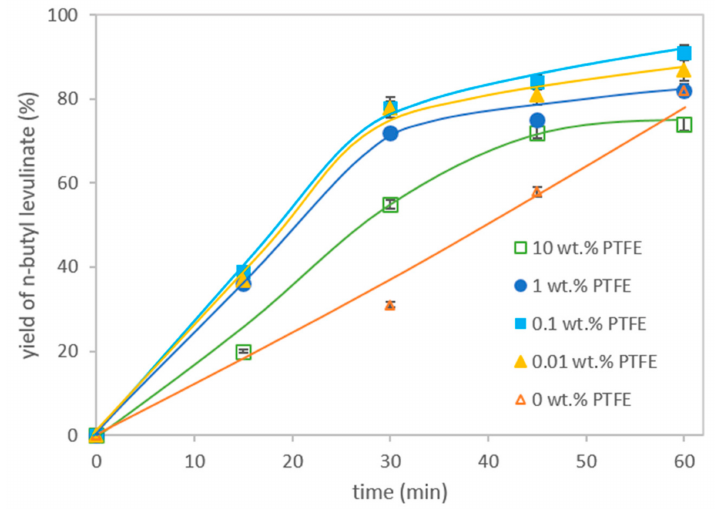
Figure 2. The effect of the amount of PTFE in CALB/MWCNT-PTFE catalyst on LA esterification. Reaction conditions: LA (0.117 g, 1 mmol); n -butanol (0.148 g, 2 mmol); CALB/MWCNT-PTFE (0.01–10.00 wt.%) biocatalyst (150 mg); n -hexane (1 mL); 20 ◦ C; 250 rpm.